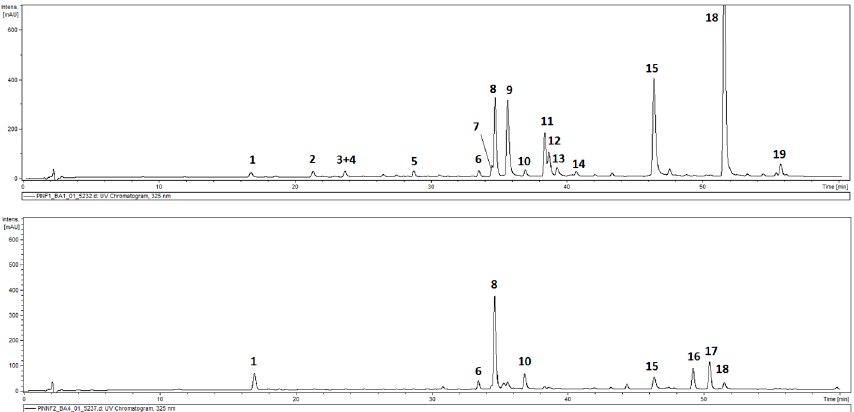
Figure 1. HPLC-UV chromatogram of Pulicaria inuloides extracts at a concentration of 10 mg/mL (2 µ L injected) acquired at 325 nm: upper part—roots, lower part—aerial parts. Compounds: 1 —5- O -caffeoylquinic acid, 2 —dicaffeoylhexaric acid (I), 3 —1,3-di- O -caffeoylquinic acid, 4